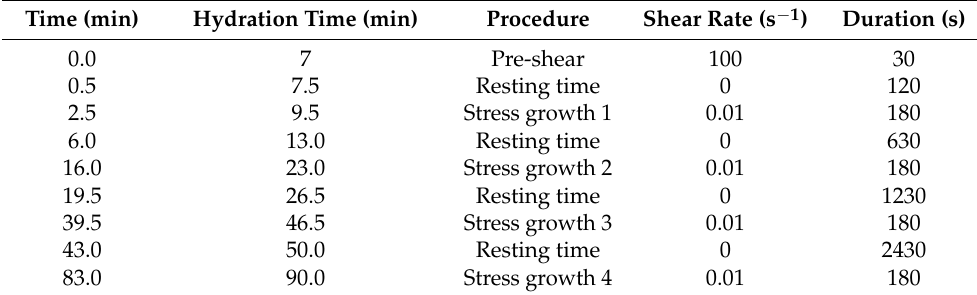
Table 2. The proposed testing method for the total structural build-up (Procedure 1).